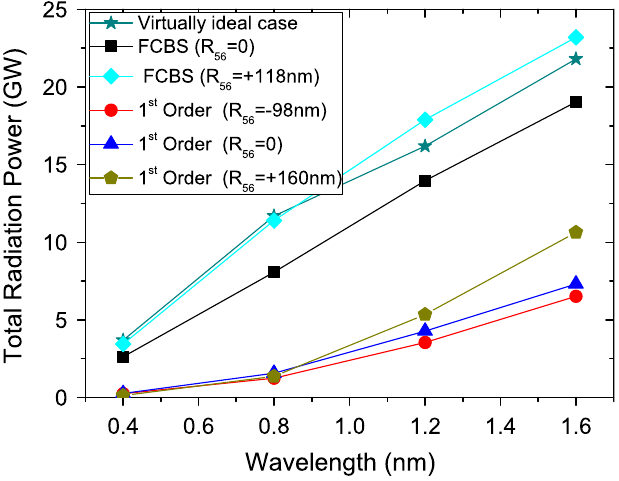
FIG. 15. (Color) Total power of a crossed planar undulator system using two 3 m long planar segments with a 90 (cid:1) phase lag installed after the different kinds of bending systems dis- cussed in this